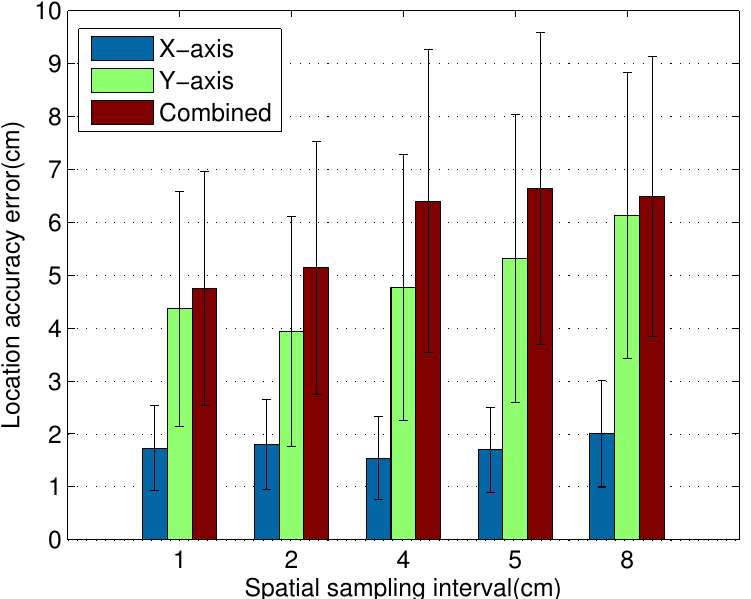
Figure 10. Localization accuracy error comparison with regard to the sampling interval. The bars represent the average localization accuracy errors in x-axis, y-axis and combined dimension, respectively. And the whiskers represent the standard deviations of the corresponding localization accuracy errors.